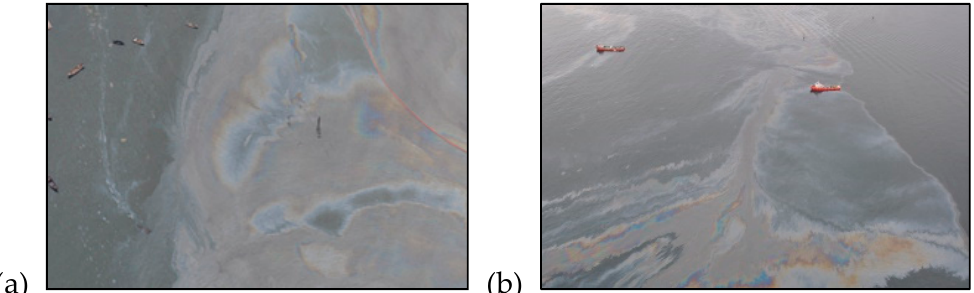
Figure 16. Oil-spill clean-up scene images. Both ( a ) and ( b ) were obtained on 21 July 2010.